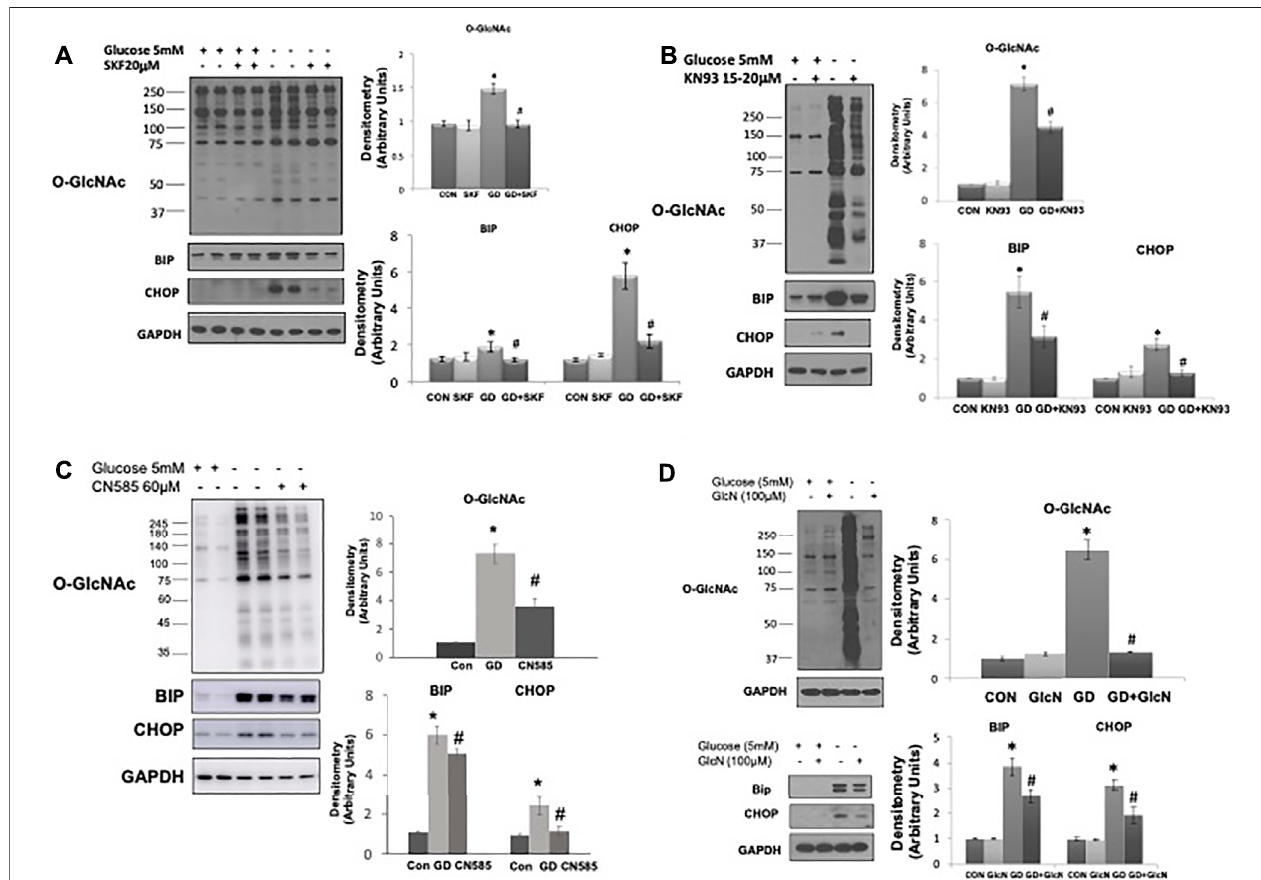
FIGURE5| TheeffectsofSKF96365, KN93, CN585, and glucosamineon theglucose deprivation inducedincrease inO-GlcNAc levelsand indicesofERstressin AC16 cells. (A) Left Panel: Immunoblots O-GlcNAc, BiP and CHOP with and without glucose in the presence or absence of SKF96365 (20 µM); Right Panels: Quanti fi cation of immunoblots normalized to GAPDH. (Note the duration of these experiments was shortened from 24 to 6 h because longer periods of glucose deprivationinthepresence ofSKF96365 resultedincelldeath; hencetheincrease inO-GlcNAc followingglucose deprivation islowerthanotherstudieswhere the experimentalperiodwas24 h), (B) LeftPanels:ImmunoblotsforO-GlcNAc,BiPandCHOPwithandwithoutglucoseinthepresenceorabsenceofKN93(20 µM);Right Panels: Quanti fi cation of immunoblots normalized to GAPDH. (C) Left Panels: Immunoblots for O-GlcNAc, BiP and CHOP with and without glucose in the presence or absenceofCN585(60 µM);RightPanels:Quanti fi cationofimmunoblotsnormalizedtoGAPDH. (D) LeftPanel:ImmunoblotsO-GlcNAc,BiPandCHOPwithandwithout glucoseinthepresenceorabsenceofglucosamine; RightPanels:Quanti fi cationofimmunoblotsnormalized toGAPDH.* p < 0.05vs.Control(Con)group;# p < 0.05vs. glucose deprivation (GD) group. All data are expressed as mean ± S.E.M. of 3 – 6 independent